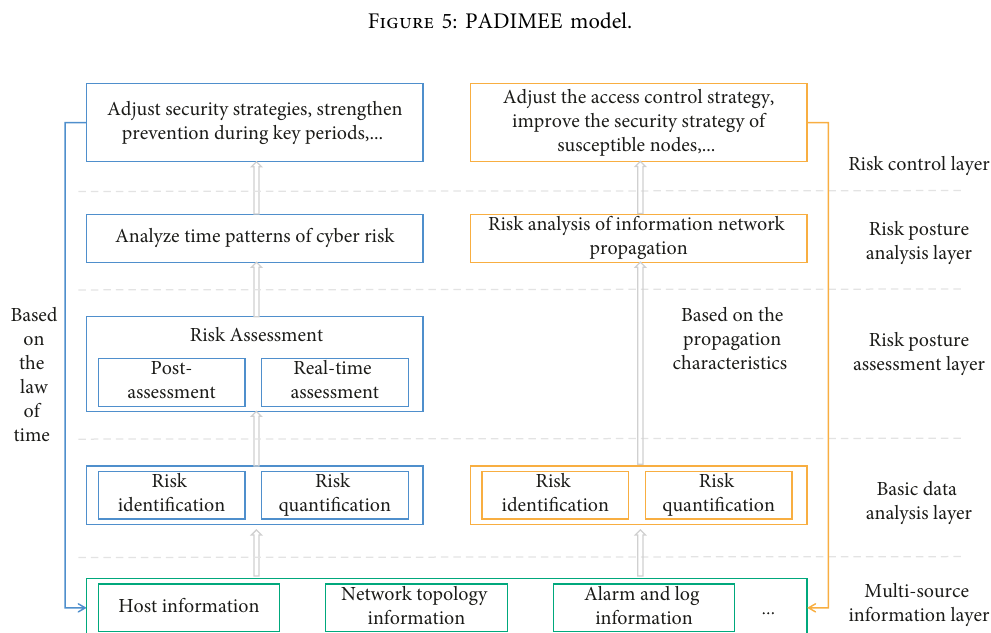
Figure 5: PADIMEE model.